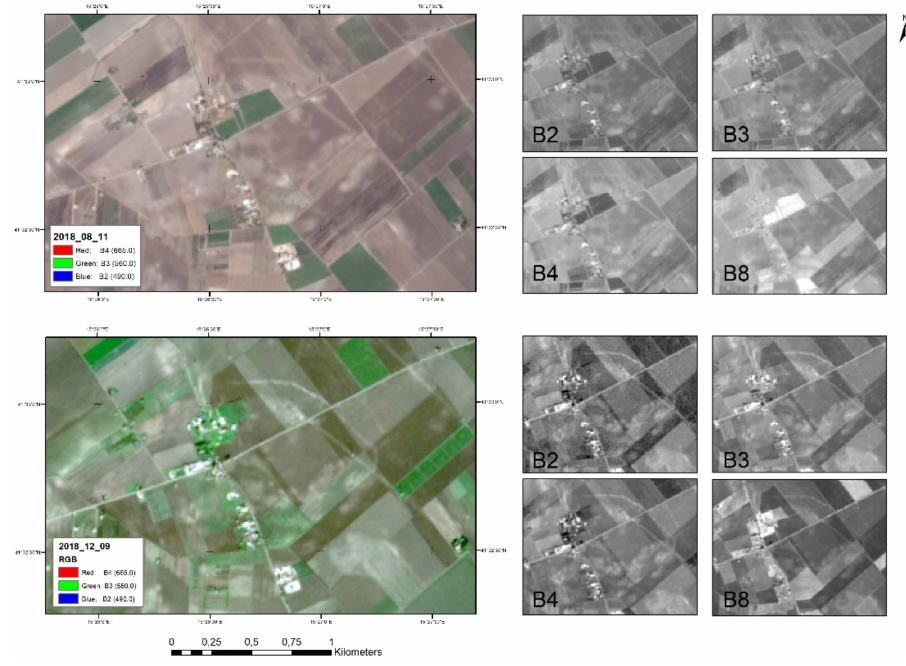
Figure 9. E.g. RGB composition and bands (Localit à